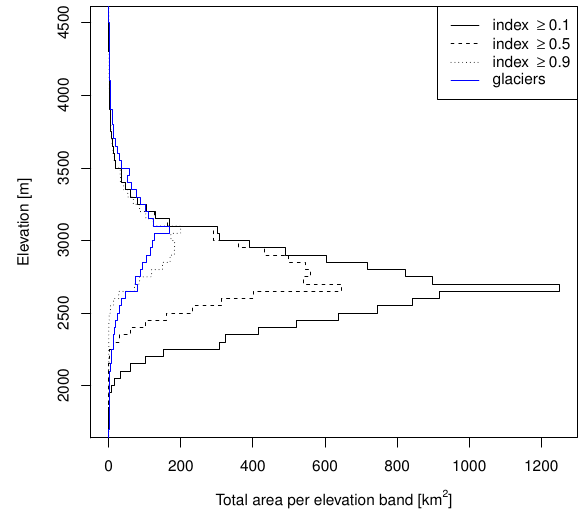
Fig. 9. Altitudinal distribution of permafrost index areas in the Alps, calculated for elevation bands of